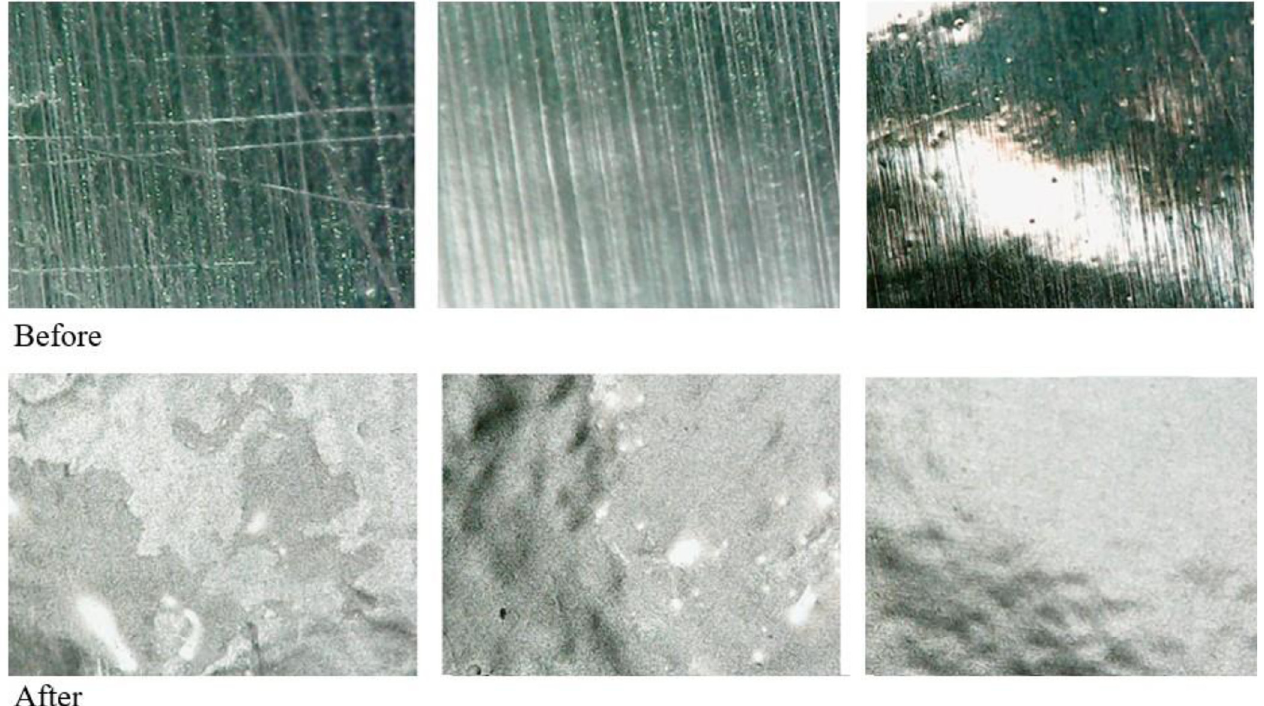
Fig. 6. Foil surface images before and after processing.